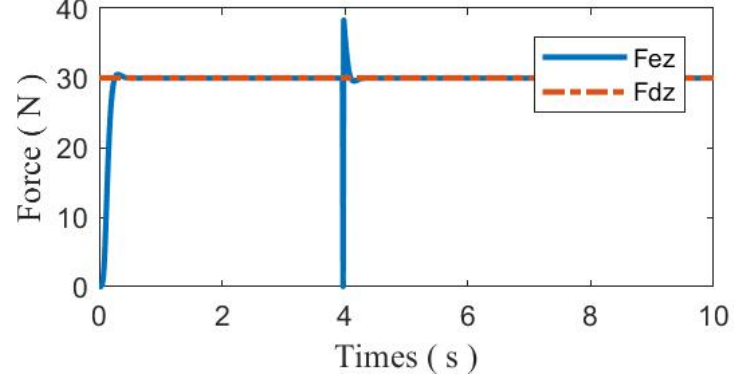
Figure 11. The contact force between shaft and hole in experiment 3.